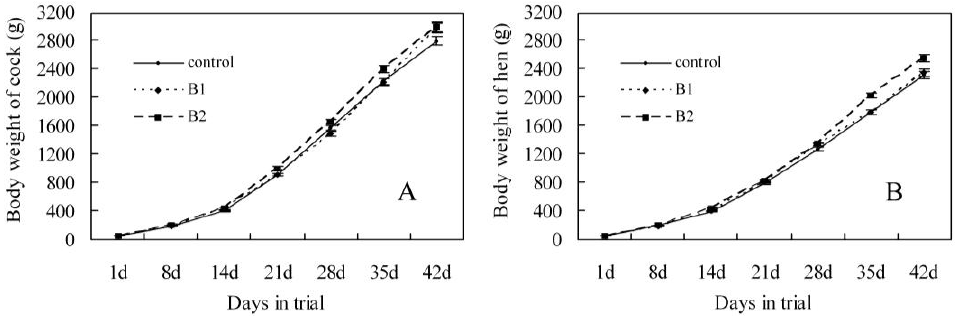
Figure 1. Evolution of broiler weekly body weight in the control group and Bacillus licheniformis supplemented groups. B1: 1 ml Bacillus licheniformis supplemented treatment; B2: 2 ml Bacillus licheniformis supplemented